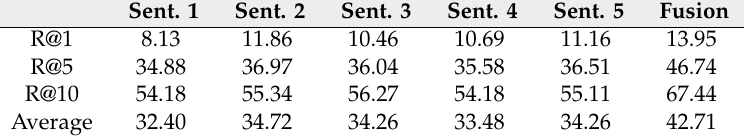
37.44 Table 4. Bidirectional text image matching results on our dataset by using VGG16. Table 2. Bidirectional text image matching results on our dataset by using ResNet50. Sent. 1 Sent. 2 Sent. 3 Sent. 4 Sent. Sent. 1 Sent. 2 Sent. 3 Sent. 4 Sent. 5 Fusion 10.93